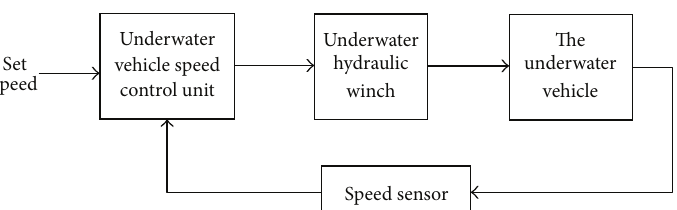
Figure 21: Fuzzy output 𝜀 .